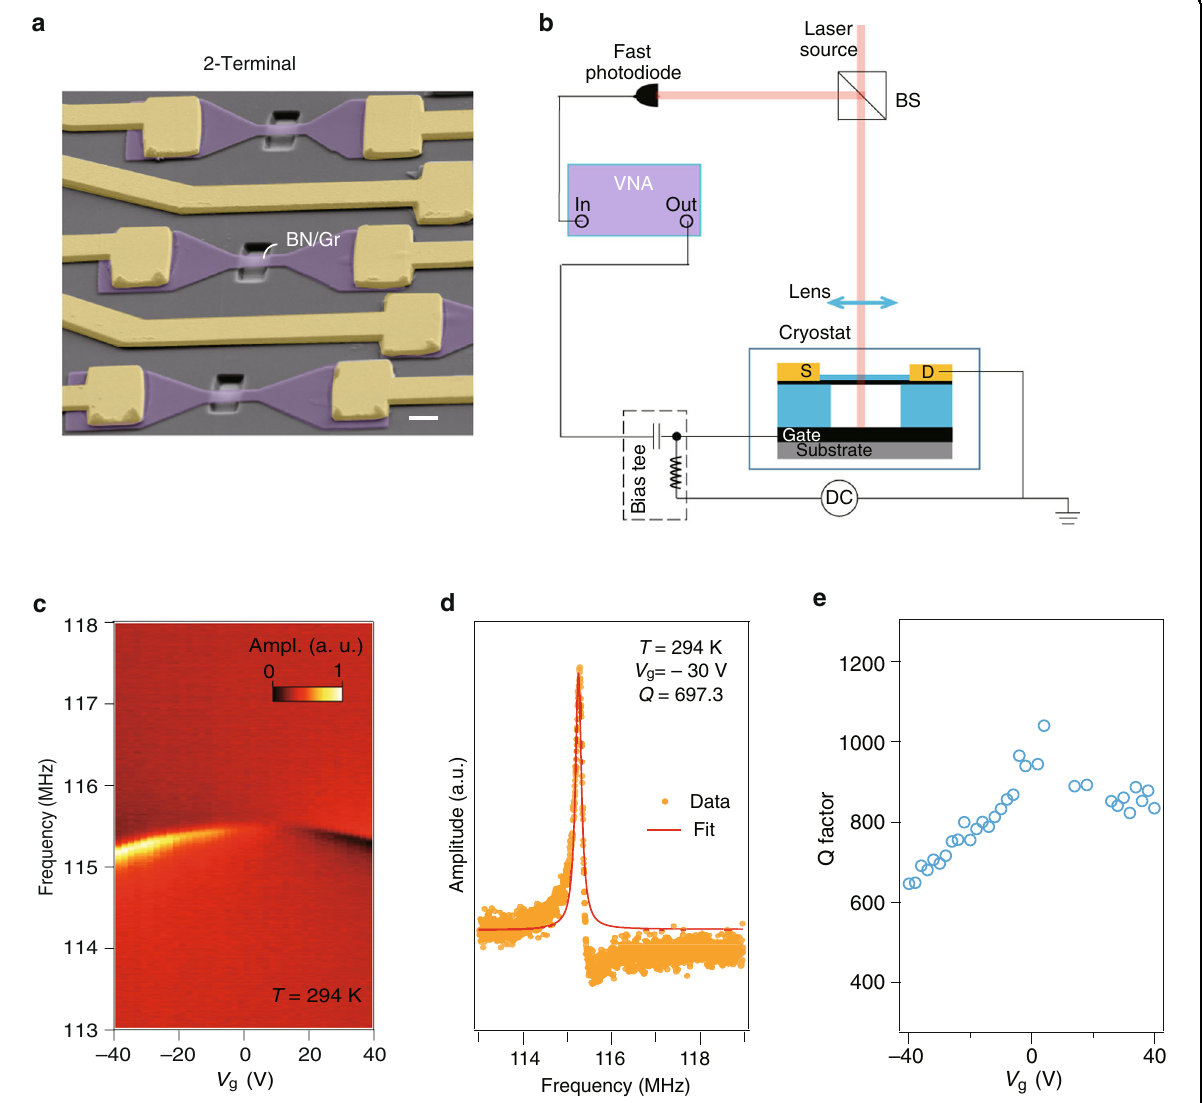
Fig. 2 Nano-mechanical resonances in vdW heterostructure NOEMS. a False colored SEM image of a typical resonator using vdW bilayer h-BN/ graphene as the suspension channel. b Schematic of the setup for optical probe of the mechanical resonance. c Color map of the resonance frequency as a function of gate voltage measured in a typical vdW NOEMS. The amplitude data with positive and negative values are mapped to a renormalized range of [0,1]. d Line pro fi le of the resonance peak at V g = – 30 V, with a Lorentzian fi t in the red solid curve. e Q factors obtained from ( c